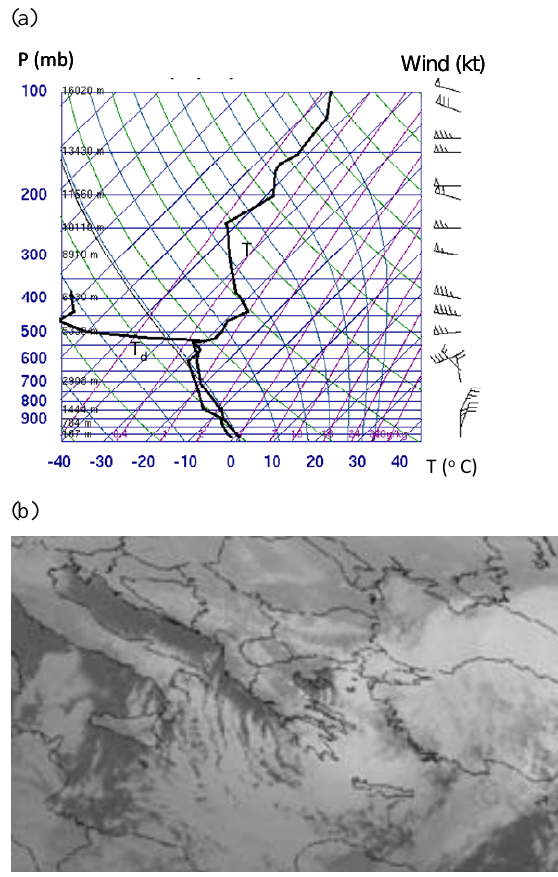
Fig. 4. Athens EPSgram based on 12 February 1200UTC-cycle. The red line represents the Fig. 2. (a) Sounding at Helliniko station (lon: 23.73 deg, lat: 37.89 deg) on 17 February at control run (50km resolution) of the EPS, the blue line represents the deterministic model run Fig. 2. (a) Sounding at Helliniko station (lon: 23.73 ◦ , lat:37.89 ◦ ) 0000UTC (source: University of Wyoming) and (b) Infrared satellite image at 0600UTC on (25km resolution), while the bars represent the percentiles of the ensemble prediction. The on 17 February at 00:00UTC (source: University of Wyoming) and 17 February (source: Meteosat MSG2). superimposed table includes indicative minimum temperatures observed in the GAA each (b) infrared satellite image at 06:00UTC on 17 February (source: Meteosat MSG2). day. It is noted that the EPS location for Athens is actually in the south of GAA.